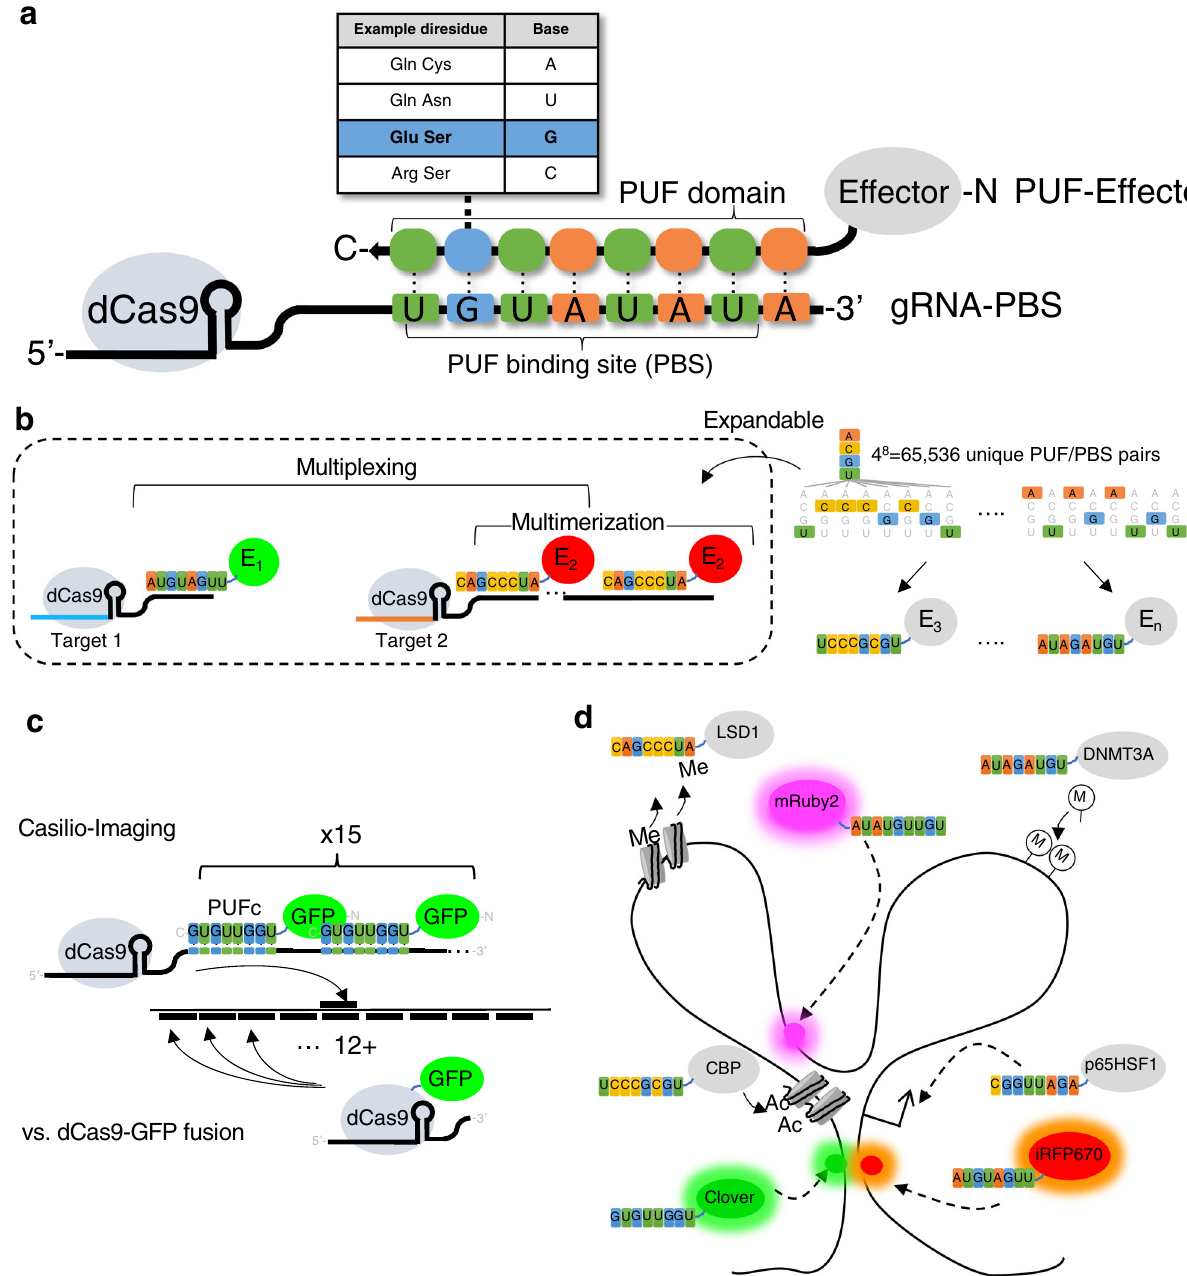
Fig. 1 Schematic of Casilio. a In Casilio, gRNA is appended with one or more binding sites for Pumilio/FBF (PUF) RNA binding domain-tethered effectors. Each PUF domain contains 8 peptide subunits each programmable to recognize one of the four RNA bases. A collection of PUF-effectors can be created by fusing different effectors to PUF programmed to recognize different 8-mer PUF binding sequence (PBS). Effectors are recruited to dCas9/gRNA-PBS complex according to the fused PUF domain. b Casilio architecture allows multiple molecules of the same or different effectors (E 1 , E 2 , … , etc.) to be recruited to a target (multimerization or complex formation) as well as different set of effectors to be recruited at different targets in the same cell (multiplexing). This system is expandable to potentially over 65,000 possible effectors. c Casilio-Imaging capitalizes on the multimerization capability to recruit 15 or more fl uorescent proteins to a target as opposed to requiring target site tiling of dCas9-GFP direct fusions using 12 or more individual gRNAs in previous studies. d The potential for Casilio to achieve multimodal operations simultaneously, for example, demethylating histone (using LSD1 module), acetylating histone (CBP), methylating DNA (DNMT3A), activating (p65HSF1) different targets, and at the same time monitoring multiple locations with different fl uorescent proteins in live cells. dCas9/gRNA-PBS not drawn for auxin-inducible degron (HCT116/RAD21-mAID) 28 that allows for its super-enhancer (IER5L-SE) 29 . We used Clover-PUFc and the conditional depletion of RAD21 by auxin treatment. A previous PUF9R-iRFP670 to label the IER5L promoter and super-enhancer, study performed Hi-C assays on this cell line and demonstrated that respectively (Fig. 4a; Supplementary Fig. 3), and performed live-cell the depletion of RAD21 resulted in loss of loop domains including a microscopy on untreated (-Auxin) (Fig. 4b; Supplementary Video 2; ~500 kb loop domain between the IER5L promoter (IER5L-P) and Supplementary Figs. 2b, 4) and RAD21-depleted ( + Auxin) cells